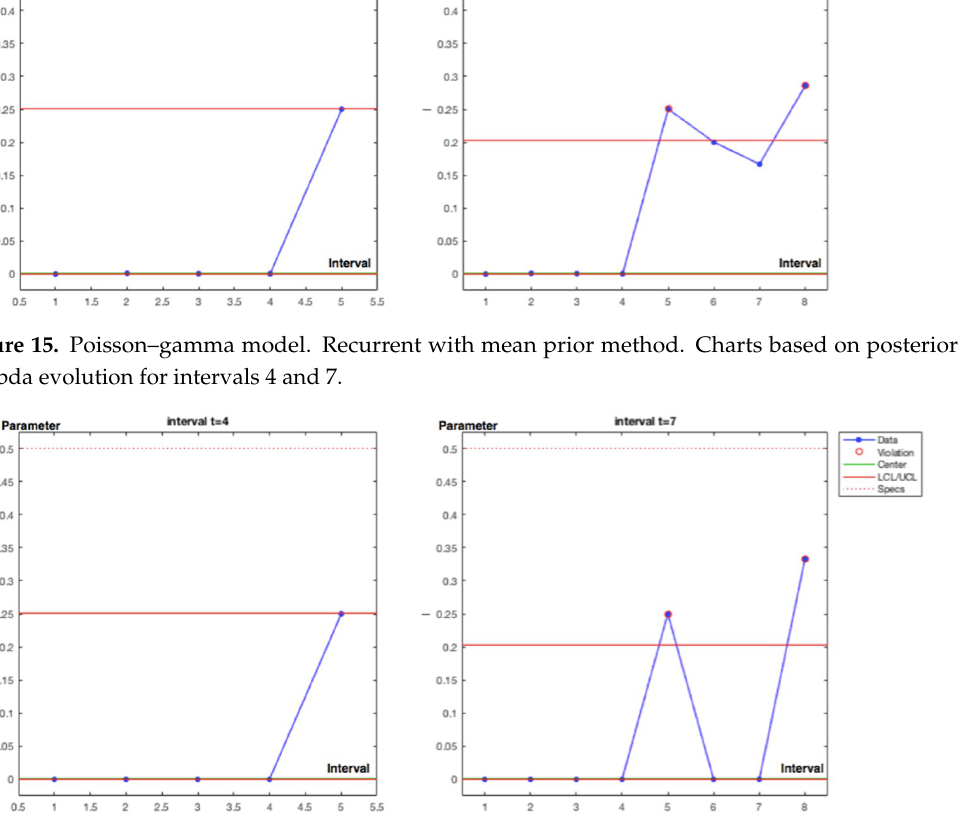
Figure 16. Poisson–gamma model. Recurrent with mean prior method. Charts based on observed lambda evolution for intervals 4 and 7.